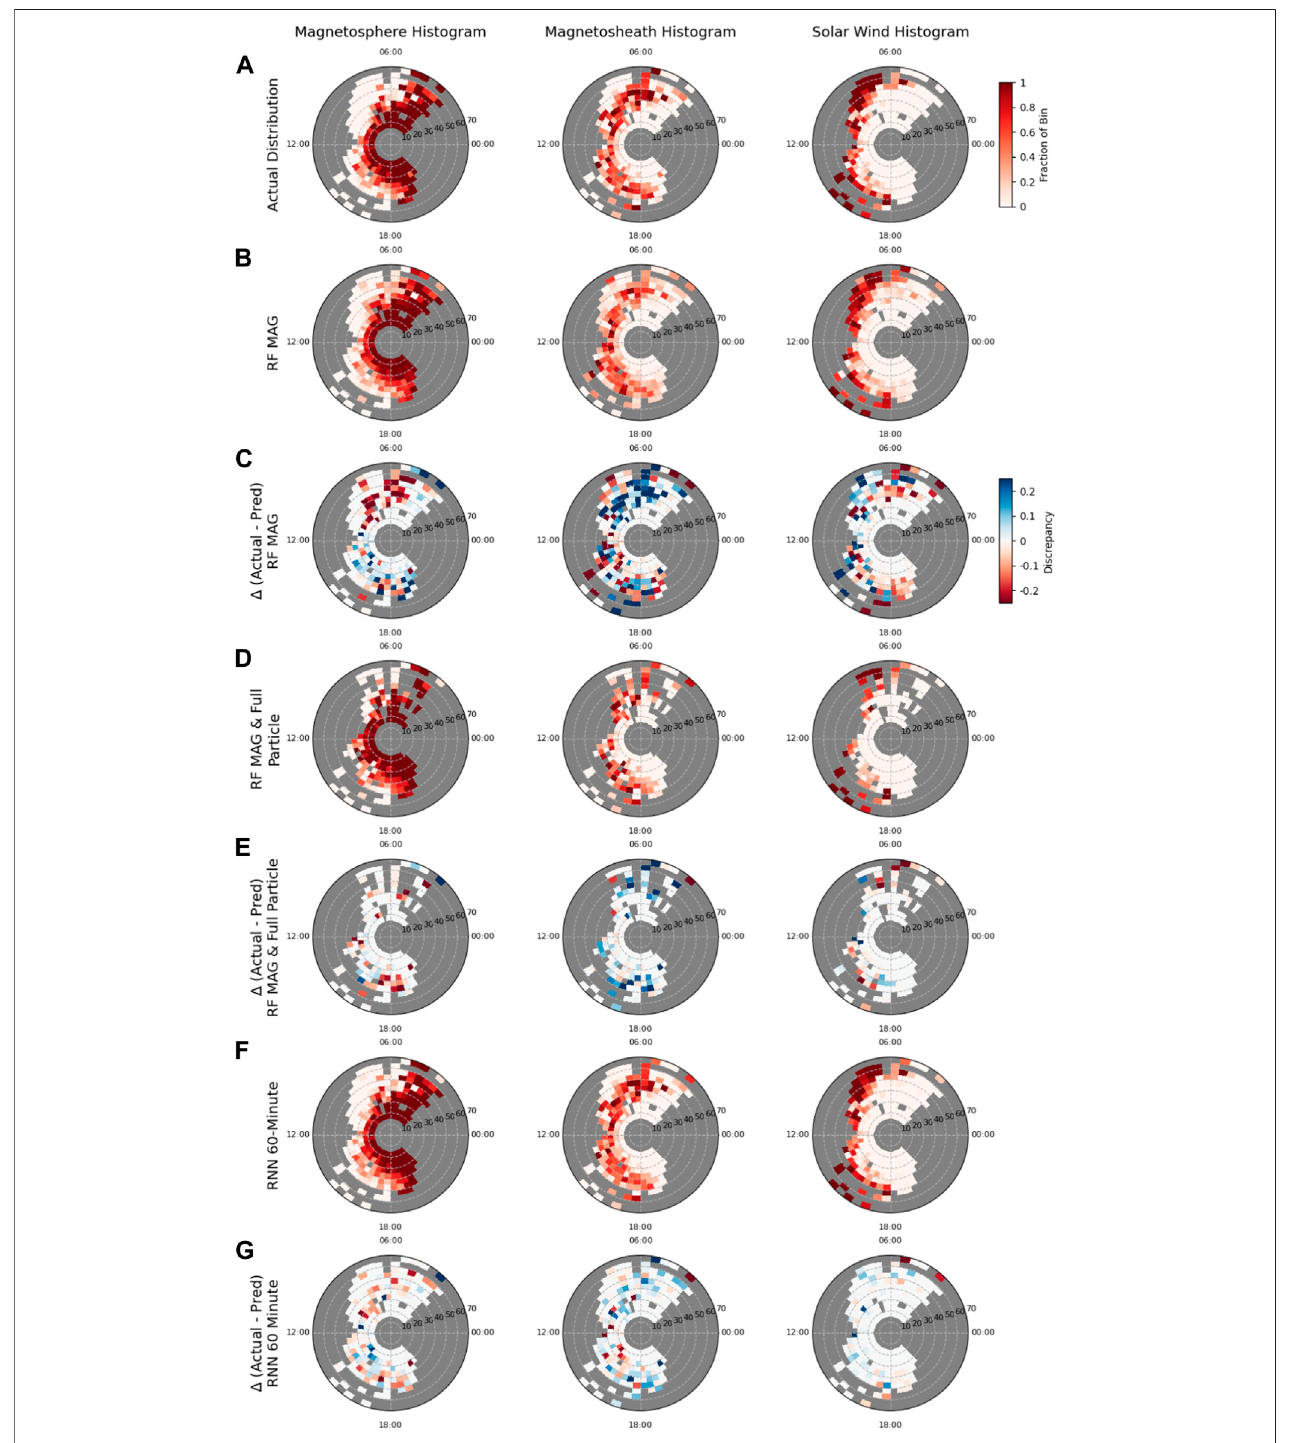
FIGURE 7 | Comparison on the spatial distribution of predictions for the magnetsophere (left column), magnetosheath (middle column) and solar wind (right column), for the true labels (A) , RF MAG-only model (B) , RF MAG & full particle model (D) and RNN 60-min MAG-only model (F) . The predictions for a particular region have been binned by local time (0.5 h increment) and radial distance (5 R S increment), with bins in gray indicating where there is no data. The discrepancy polar histograms (C,E,G) showsthedifferencebetweentheobservedfractionofabinlabeledasaparticularregion (A) andthepredictedfraction (B,D,or,F) ,highlighting model errors. Discrepancy bins trending toward red indicate where the model has over-predicted a region, while blue indicates where a model has under-predicted a region. Panels (B,D,F) share the colorbar in panel (A) , while panels (E,G) share the colorbar for panel (C) .